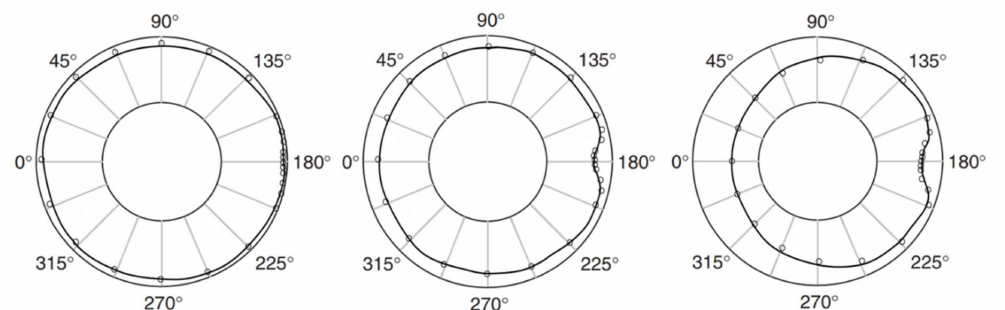
Figure 13. Comparison of simulated and measured maximum vertical runup heights for a solitary wave runup on a conical island: A/h = 0.045 ( left panel ), A / h = 0.096 ( middle panel ), A / h = 0.181 ( right panel ). Experimental data (circles), numerical results (solid